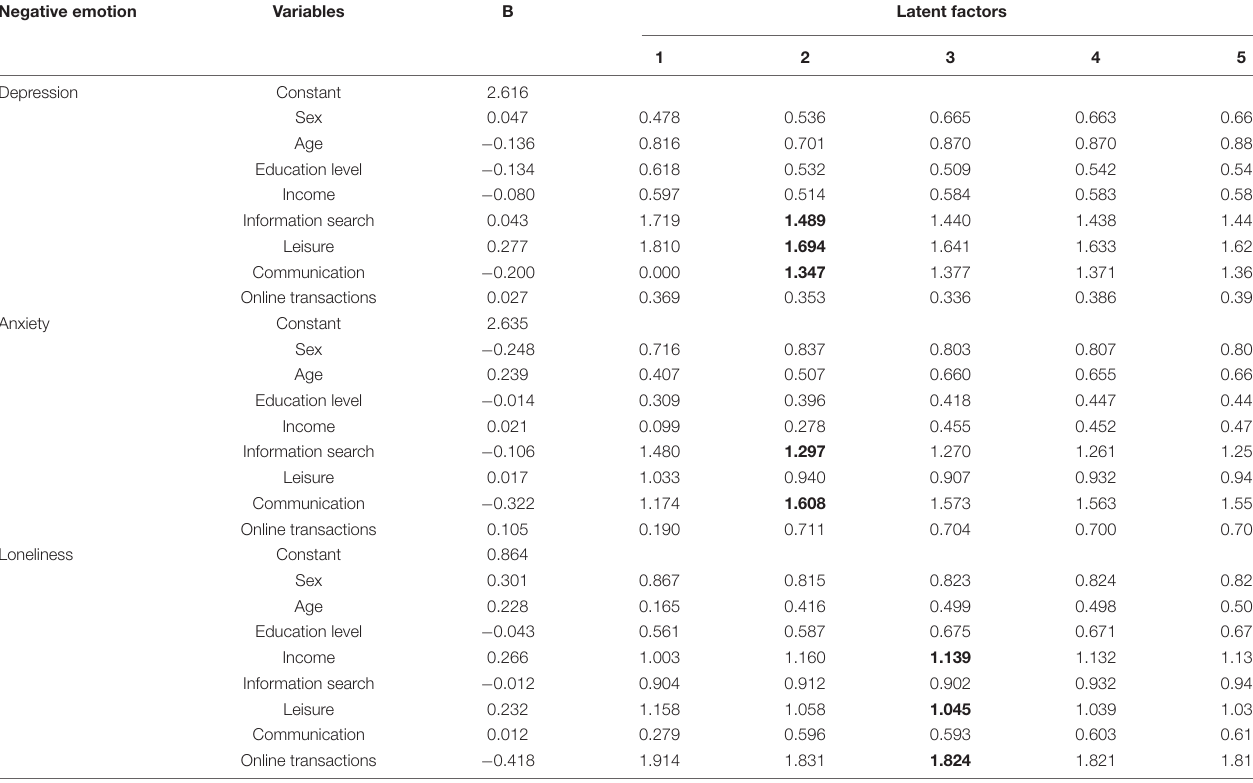
TABLE 3 | The PLS regression analysis